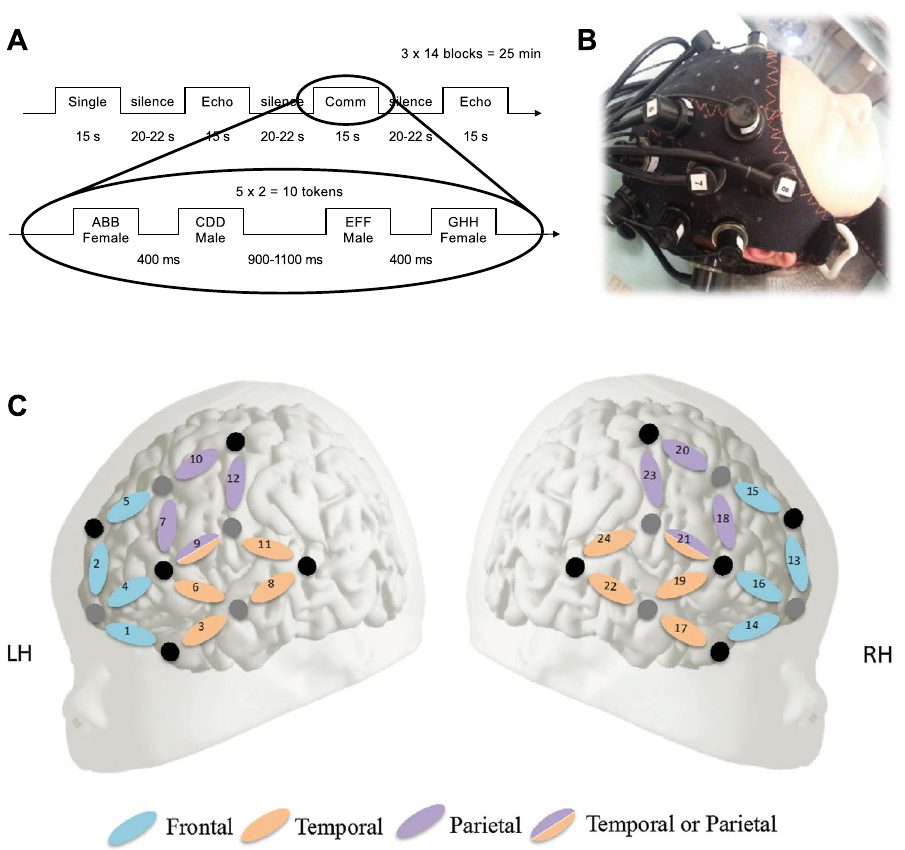
Figure 2. Experimental procedures and channel layout. ( A ) Experimental design. The study was construed in a block design. Blocks of the three experimental conditions and trials within each block were pseudorandomized. ( B ) An fNIRS cap mounted on a newborn. ( C ) Channel layout and spatial localization in the present study, figure adapted from 13 . Permission was granted by parents for publishing